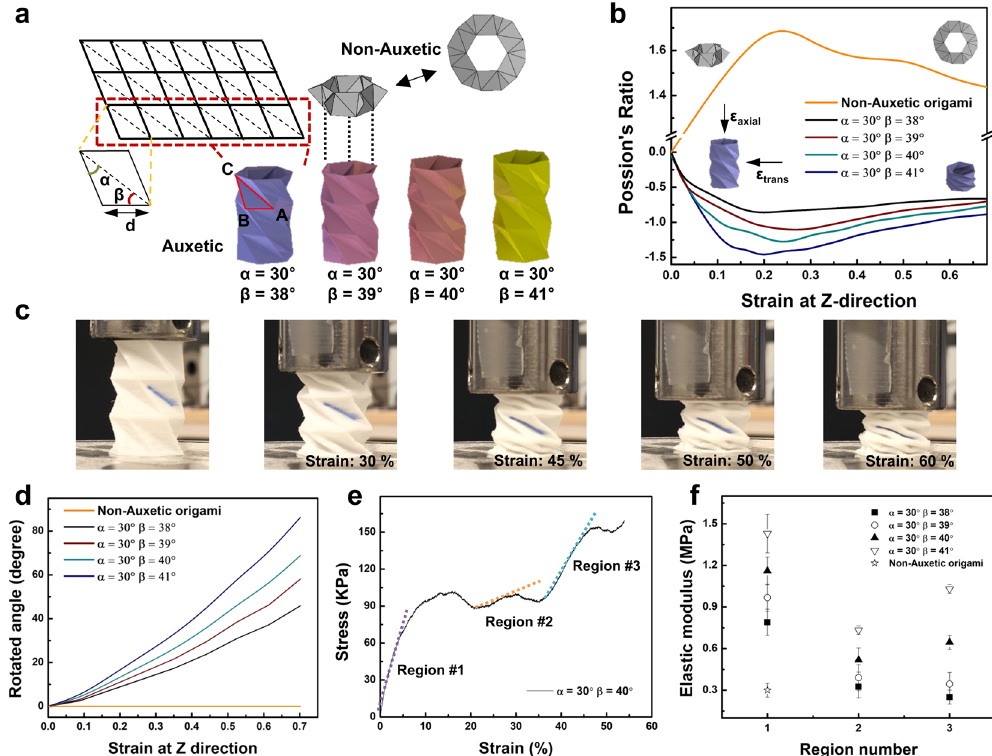
Fig. 3 Parametric study for the optimization of LIO. a Schematics of different leech-inspired origami (LIO) designs. The auxetic origami is tailored by changing the angle of triangular patterns. b Poisson ’ s ratio of the non-auxetic and auxetic parts of the LIO at the z -directional strain. c Actual images of auxetic origami to represent transverse strain ( ε trans ) at z -directional compression ( ε axial ). d Rotated angles at the z -directional compression. e The stress – stain curve of the LIO design with the angular of σ = 30°, β = 40°. f Elastic modulus of LIO designs with different angles. Error bars represent the standard